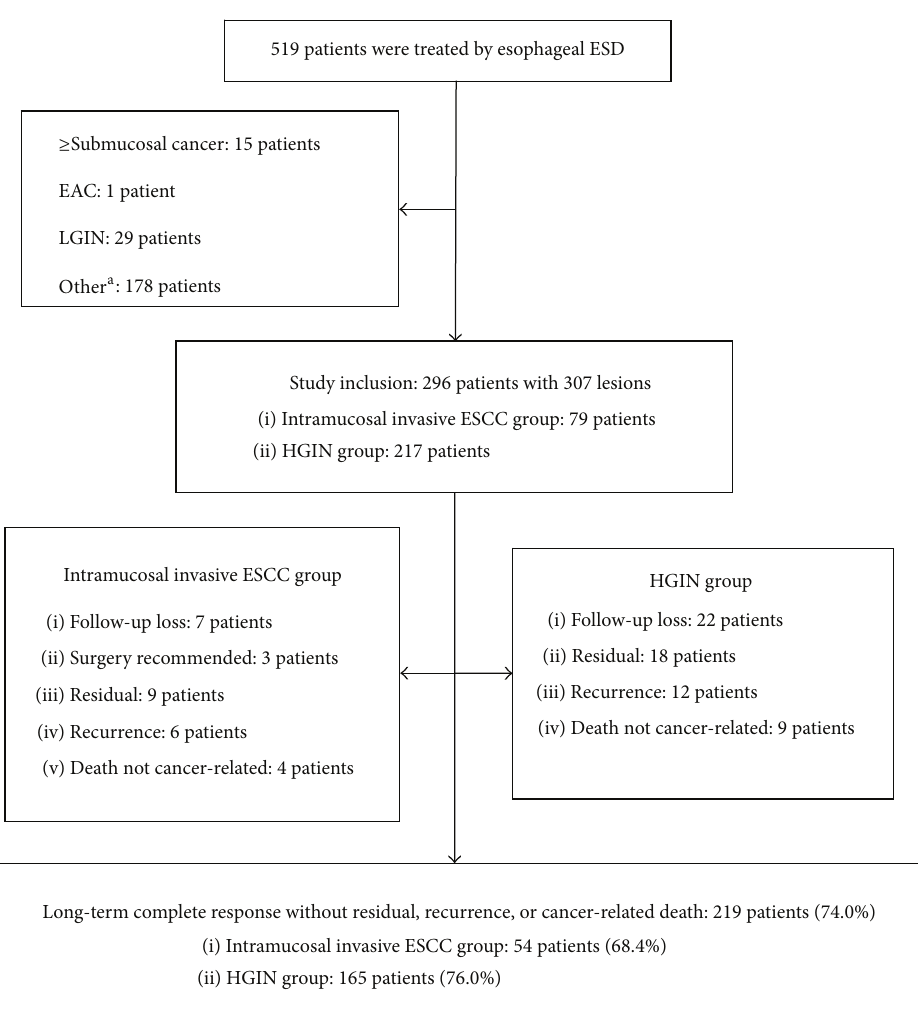
Figure 1: Flow diagram for the study patients. ESD: endoscopic submucosal dissection; EAC: esophageal adenocarcinoma; LGIN: low- grade intraepithelial neoplasia; ESCC: esophageal squamous cell carcinoma; and HGIN: high-grade intraepithelial neoplasia. a Main including leiomyoma, stromal tumor, inflammation, and epithelial